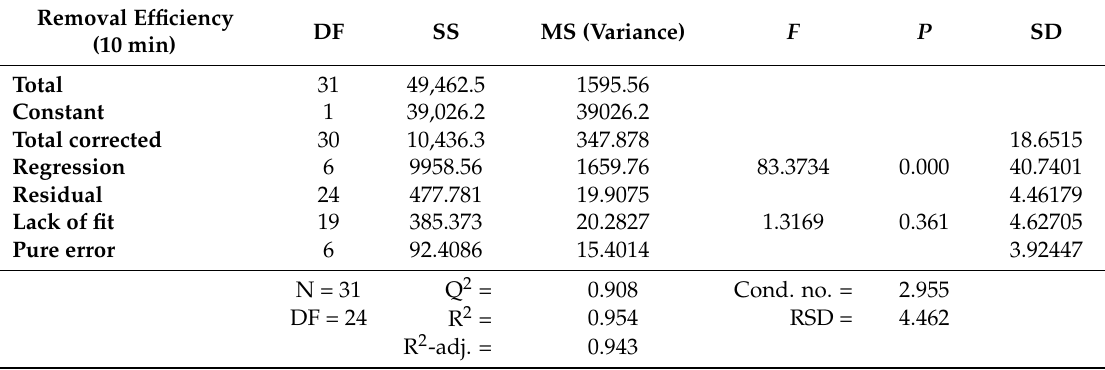
Table 4. Analysis of variance (ANOVA) for variables and the regression